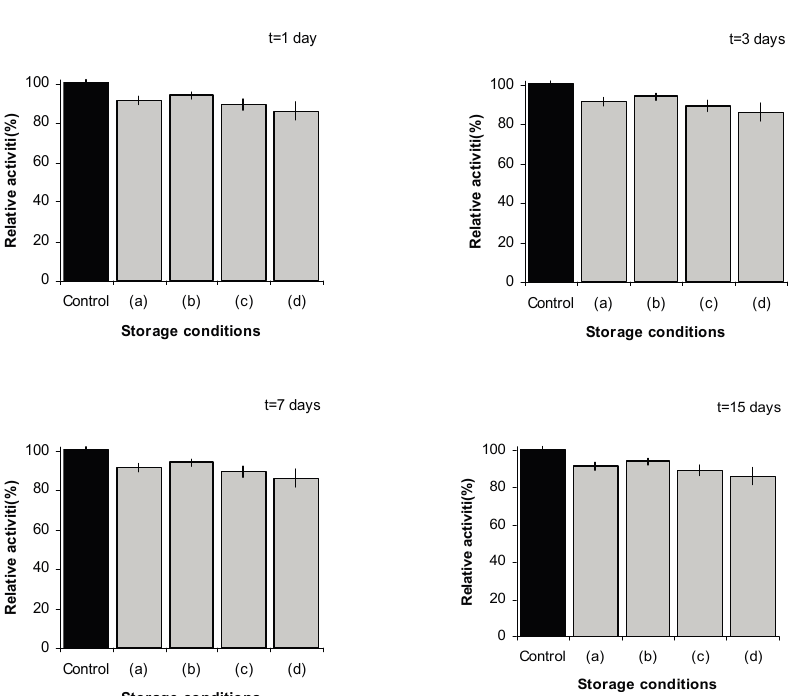
Figure 3. The film prepared for assaying.